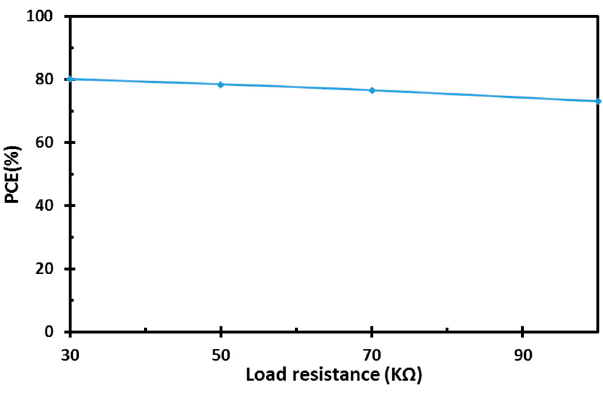
Figure 15. Post-layout simulation result of the peak PCE for different resistive loads.